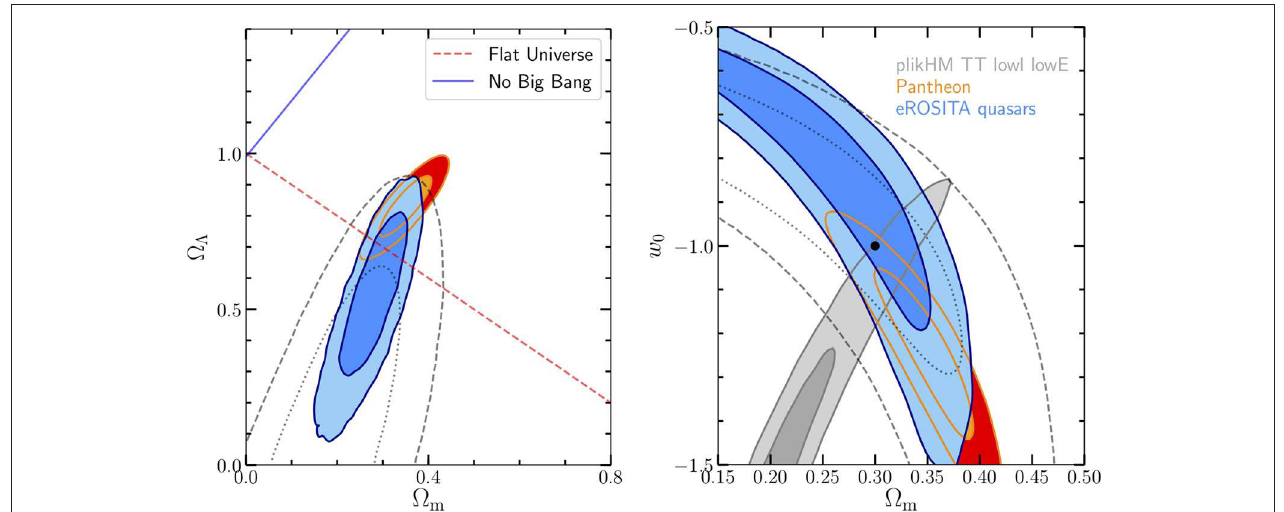
FIGURE 2 | (Left) Confidence contours at 68 and 95% levels for the (cid:127) m and (cid:127) 3 cosmological parameters in the 3 CDM model, where both (cid:127) m and (cid:127) 3 are free to vary. All the plotted uncertainties are statistical. Orange/red contours: Pantheon . Blue/cyan: eROSITA simulated sample. (Right) Confidence contours at 68 and 95% levels for the (cid:127) m and w 0 cosmological parameters in the w CDM model. All the plotted uncertainties are statistical. Orange/red contours: Pantheon . Filled dark/light gray: Planck constraints from a Plik TT+low l +lowE likelihood. Blue/cyan: eROSITA simulated sample. The dashed/dotted contours represent the constraints on the